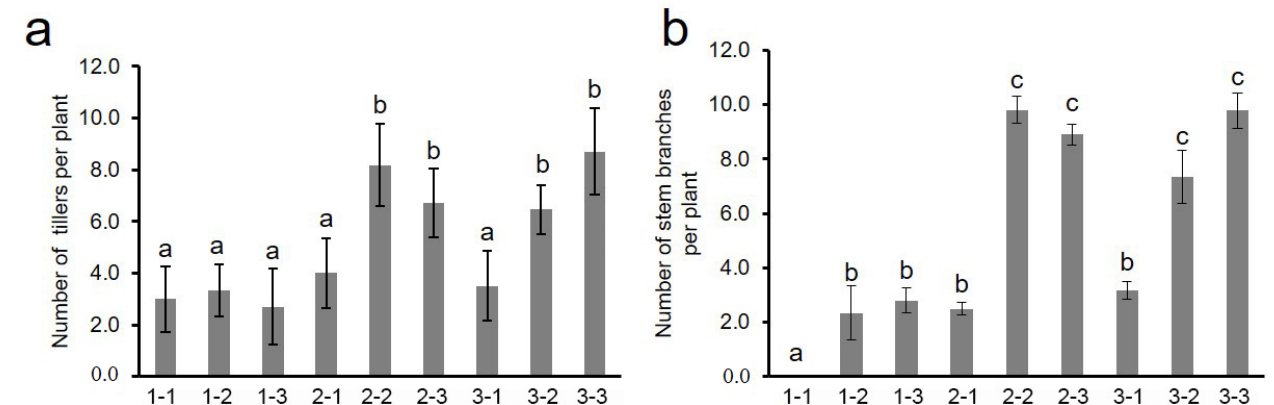
Figure 4. Effects of different genotype combinations of two QTLs on branch trait. ( a ) Number of tillers per plant. ( b ) Number of stem branches per plant. 1, 2, 3 indicated homozygotes of YD1, and homozygotes and heterozygotes of IL-J85, respectively; the number in front and behind represent qSBR1 and qSBR5 , respectively. The different letters above each bar indicated statistically significant differences as determined by one-way ANOVA followed by Tukey’s multiple comparison test ( p < 0.05).